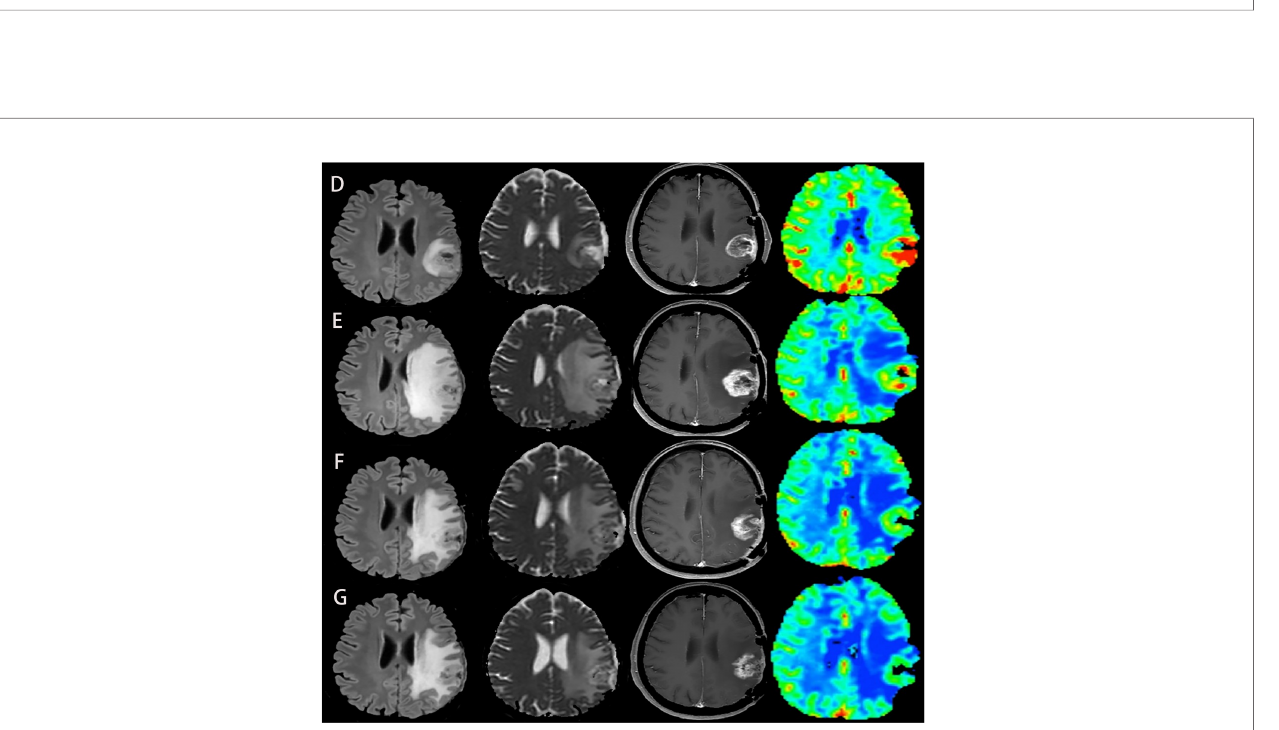
FIGURE 2 | Another case of glioblastoma developed pseudoprogression during immunotherapy, with FLAIR, ADC map, T1-enhanced, and CBV map from left to right. (D – G) MRI was performed before immunotherapy and 2, 4, and 6 months after immunotherapy, respectively. Although tumor recurrence was suspected at the second month, the subsequent two MRI showed that the lesion became smaller, the degree of edema and imitation of diffusion alleviated, and the perfusion decreased. These two cases demonstrate that the combination of conventional MRI and advanced MRI imaging can accurately identify pseudoprogression and tumor recurrence of glioblastoma after immunotherapy. The above two fi gures were reproduced with the permission of (29) (Copyright at Multidisciplinary Digital Publishing